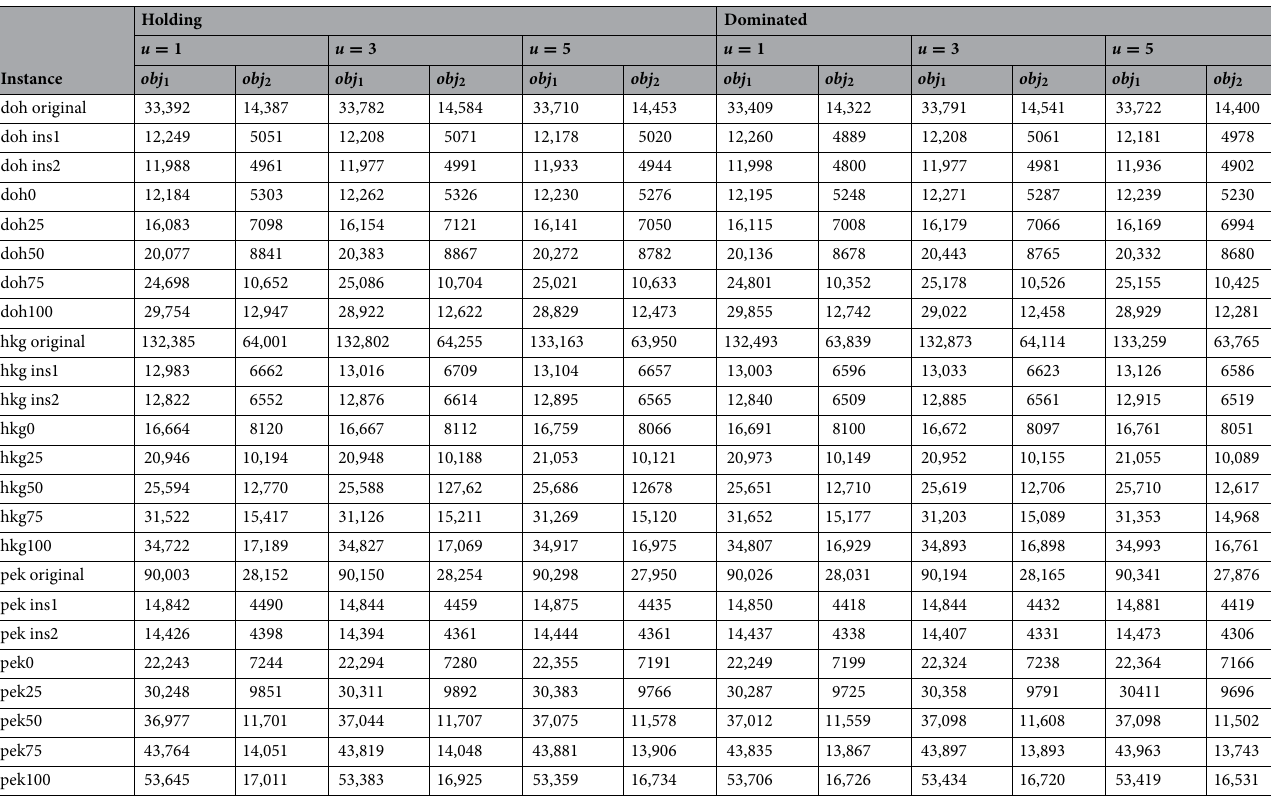
Table 7. Full results for experiments with dominated speed